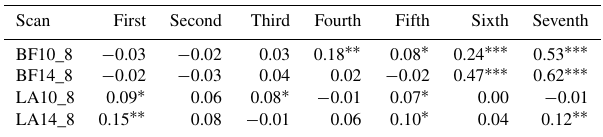
Table 6. Coefficients ( R 2 ) for the regression function relating the ultrasound measurements at the eighth scan to corresponding mea- surements at the previous